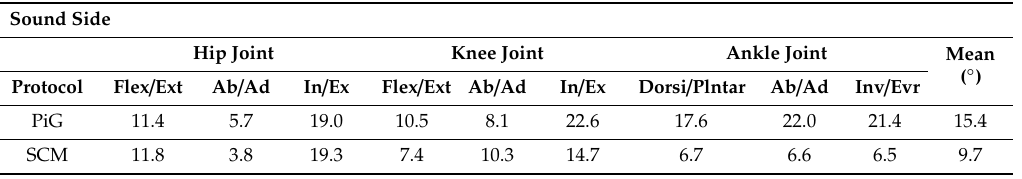
Table 11. Between-subject variability illustrated by the mean standard deviation over the sound gait cycle among the seven participants for both